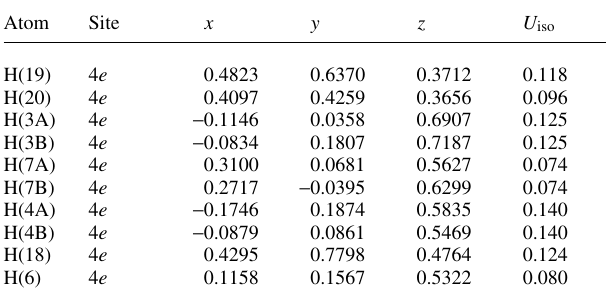
Table 2. Atomic coordinates and displacement parameters (in Å 2 )